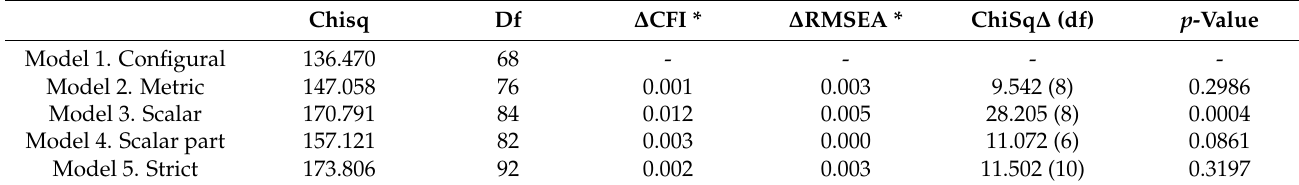
Table 3. Differences between